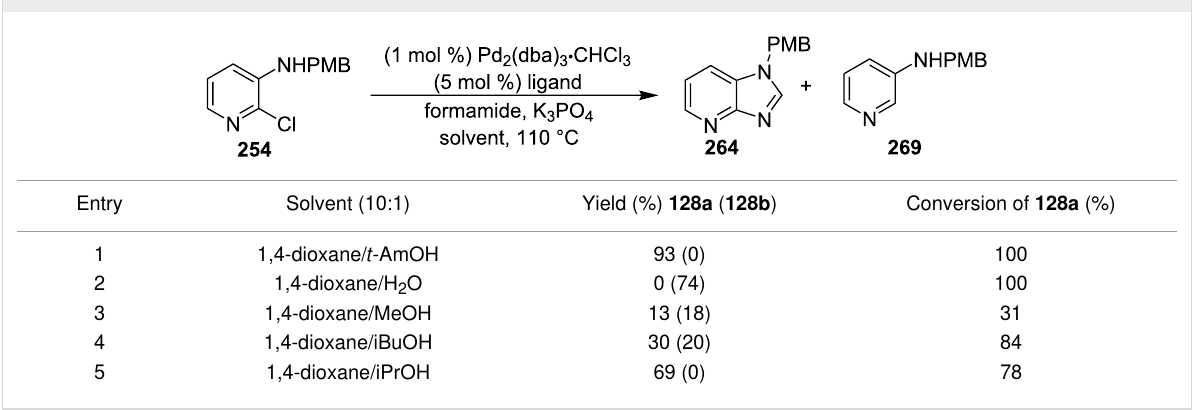
Table 9: Optimization of the solvent